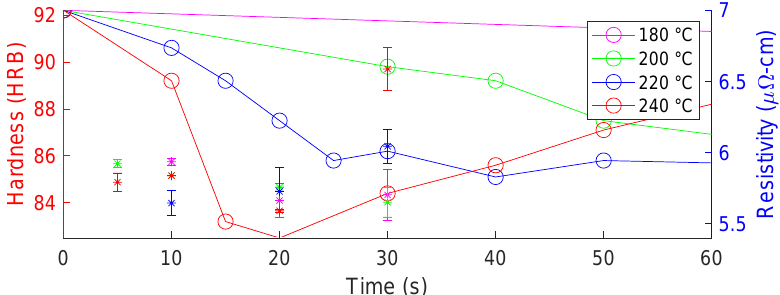
Figure 21. Comparison of electrically assisted heat treatment and hardness data presented in [8]: circle data points represent [8] hardness, star data points represent resistivity values from the present